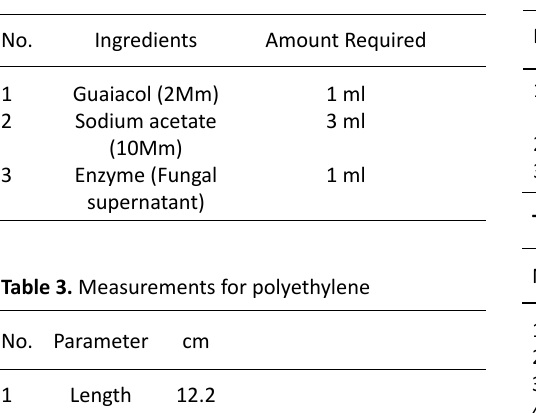
Fig. 3. Effect of pH on enzyme Table 2. Composition for Guaiacol assay